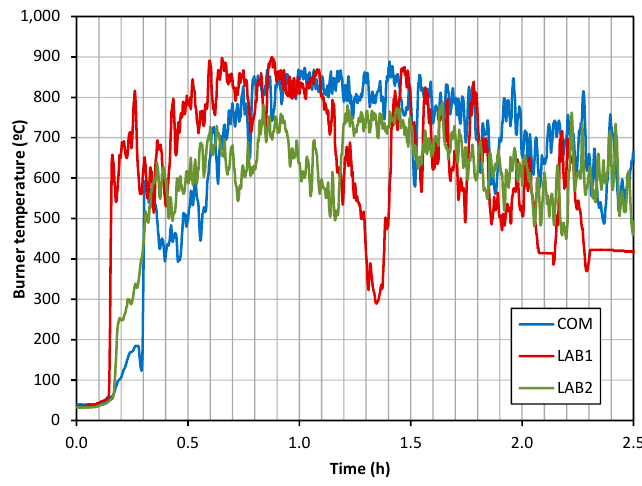
Figure 13. Burner temperature during combustion tests.